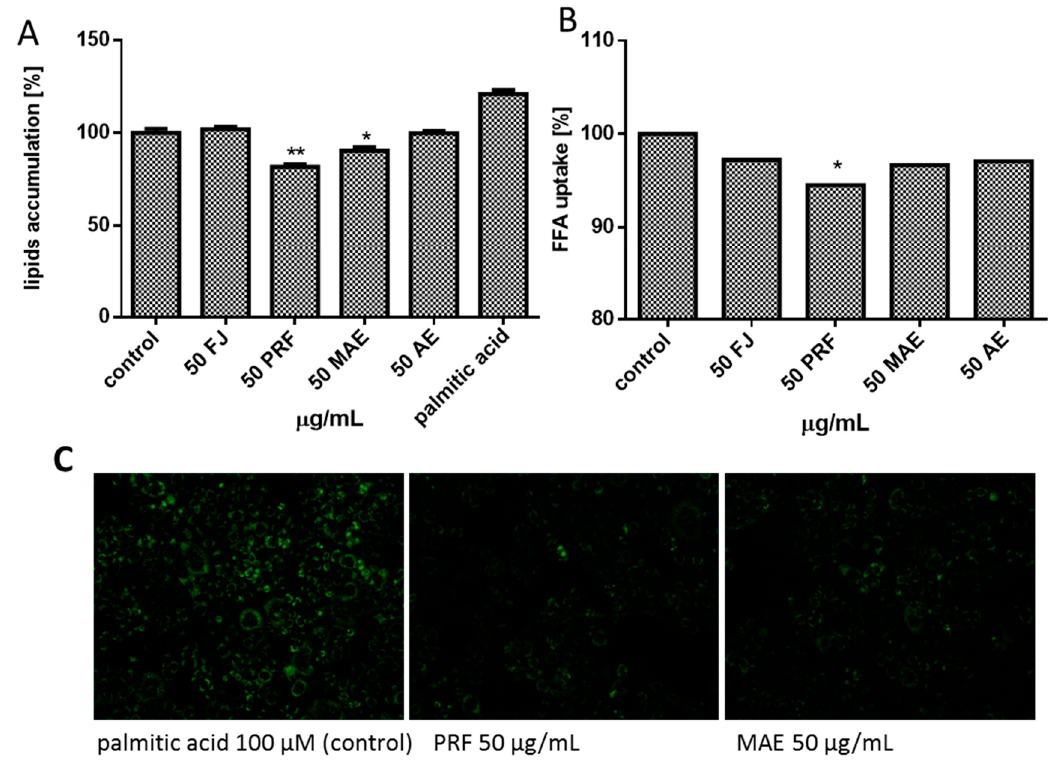
Figure 11. The influence of 24 h exposure of V. opulus juice (FJ), PRF (phenolic rich fraction), MAE (methanol-acetone extract) and AE (acetone extract) at 50 µ g / mL on Caco-2 cells in the presence of 100 µ M palmitic acid on the cellular lipid accumulation obtained with Nile red assay ( A ). The influence of 24 h exposure of extracts on fatty acid analogue TF2-C12 uptake measured with FFA-uptake assay ( B ). The influence of the PRF and MAE extracts on the accumulation of lipid droplets in Caco-2 cells stained with Nile red was observed by treating cells with the extracts for 24 h in the presence of palmitic acid (100 µ M). High fluorescence in positive control cells after incubation with palmitic acid was observed. Fluorescence microscopy (Nikon TS100 Eclipse, Japan), 200 × magnification. Images are representative of one of four similar experiments ( C ). Control cells were not exposed to any compound but the vehicle; values are means ± standard deviations from at least three independent experiments; statistical significance was calculated versus control cells (untreated) * p ≤ 0.05, ** p ≤ 0.01.